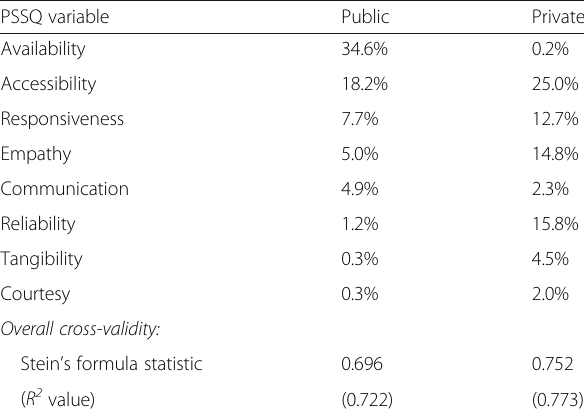
Table 6 Proportions of variations in clients ’ satisfaction level by multiple regression models in public and private sectors PSSQ